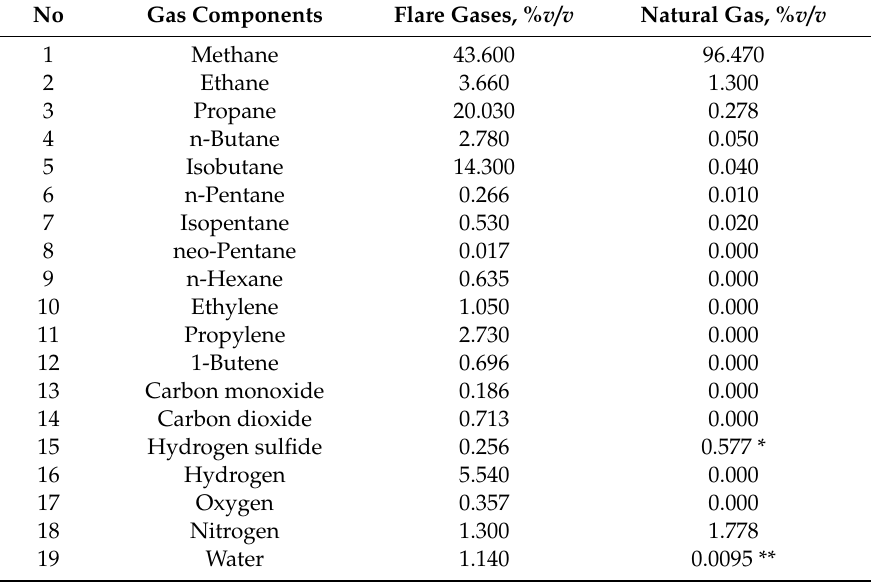
Table 1. The average composition of the flare gases and natural gas